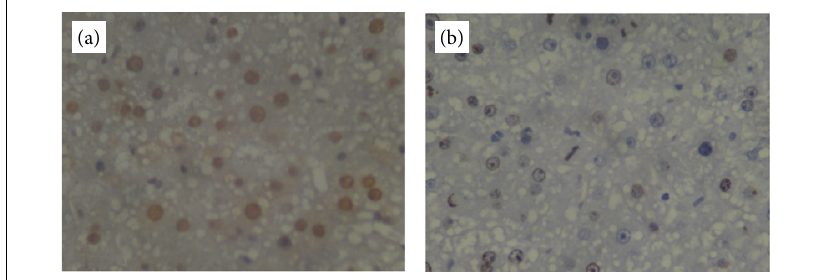
Figure 3 - Microphotographs of immunohistochemical staining (brownish colour) for PCNA (a) and Ki-67 (b) in liver tissues of CG